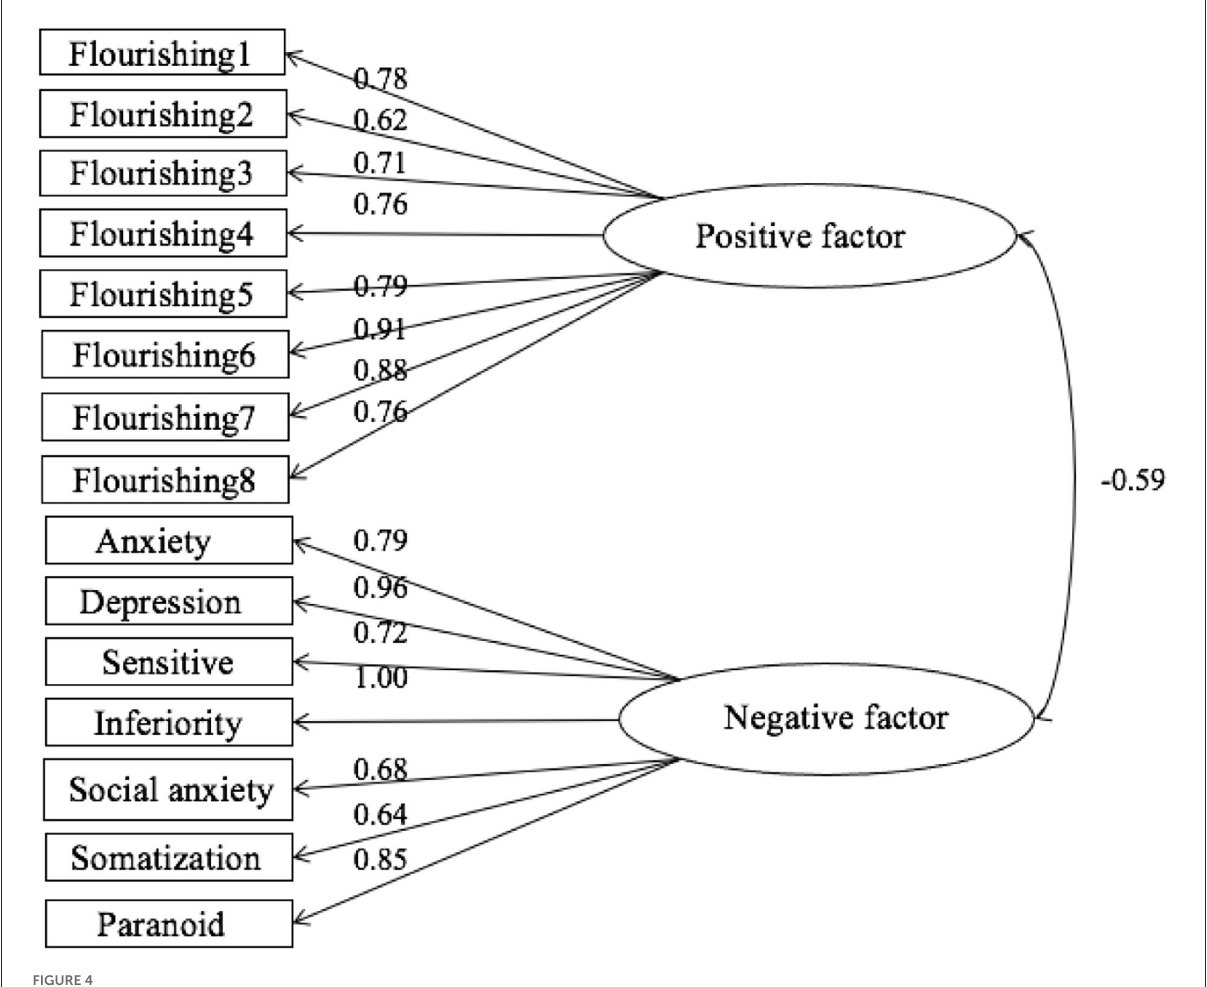
FIGURE4 Fitting path data of the dual-factor mental health model.